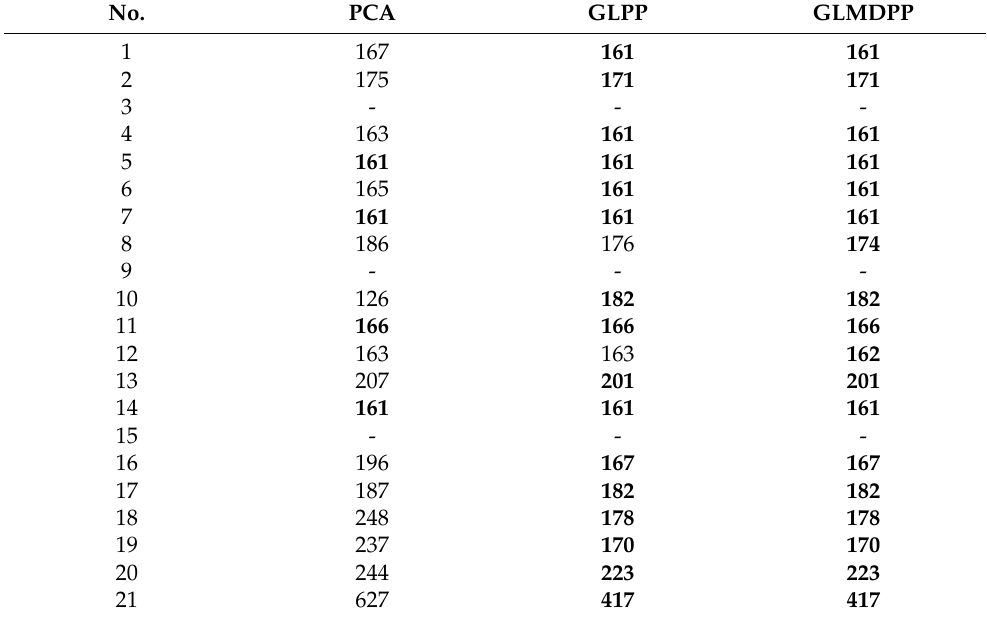
Table 4. Fault detection time of different method on TE